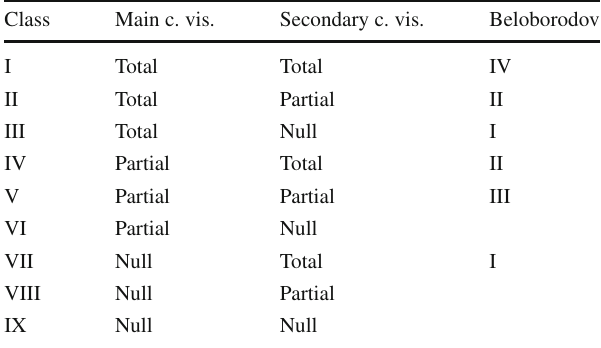
Table 2 New classification system for pulsars with two distinguishable non-antipodal caps, compared to Beloborodov’s